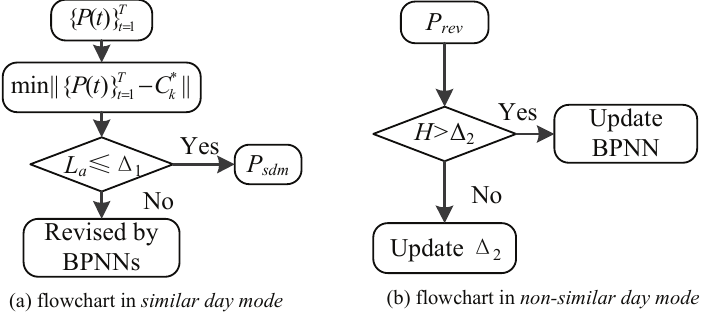
Figure 6. The flow chart for searching similar